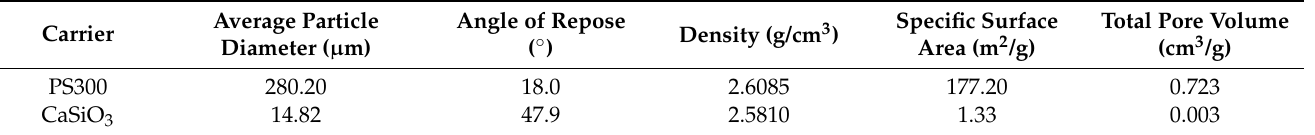
Table 2. The characteristics of PS300 and CaSiO 3 .